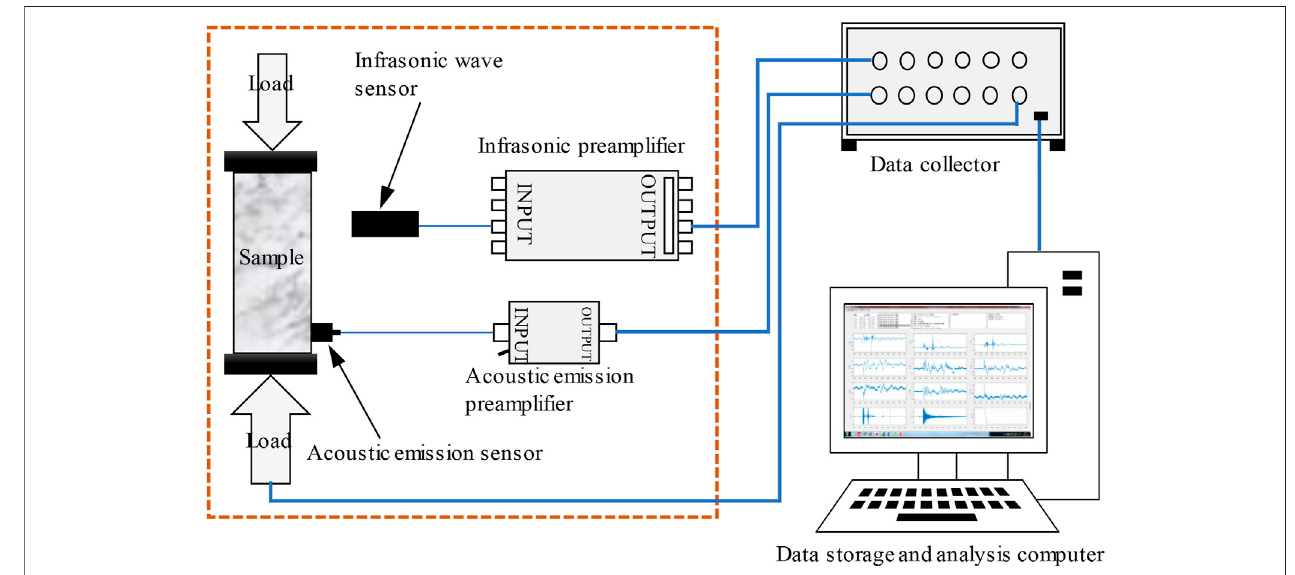
FIGURE 1 | Schematic diagram of experimental